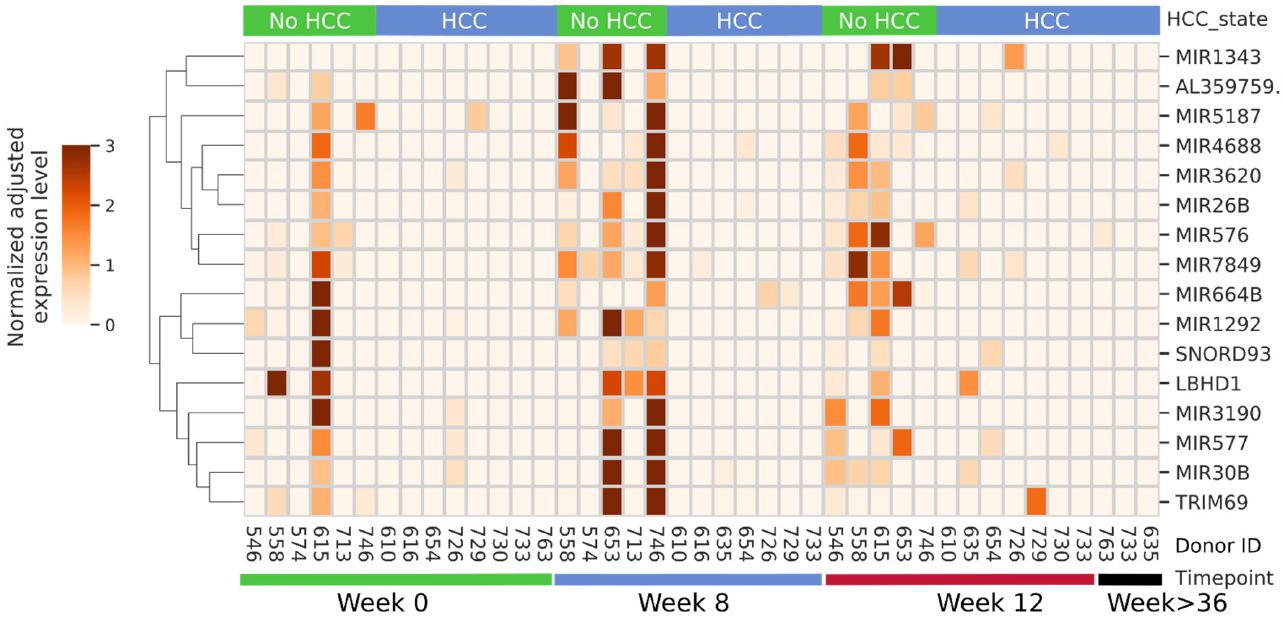
Figure 1. miRNAs predominantly or exclusively detected in the non-HCC group during the time course of this study. Donor IDs and the time point of each sample are indicated at the bottom, and the subsequent development of HCC, or lack of it, is shown at top. miRNA identity is shown on right, while normalized expression level key and hierarchical clustering is shown on left.